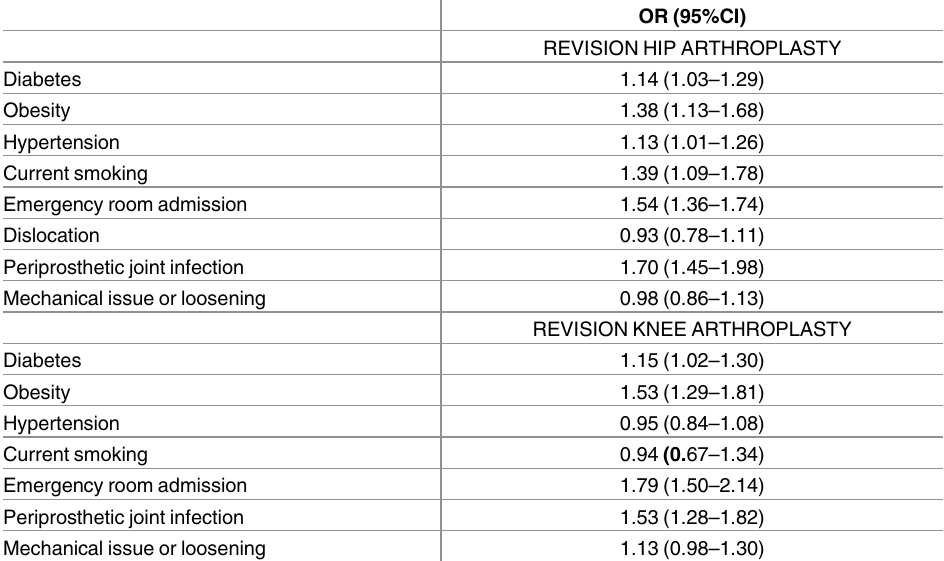
Table 4. Logistic regression analysis of the factors associated with in-hospital postoperative compli- cations in all patients after revision hip arthroplasty and revision knee arthroplasty in Spain (2005–